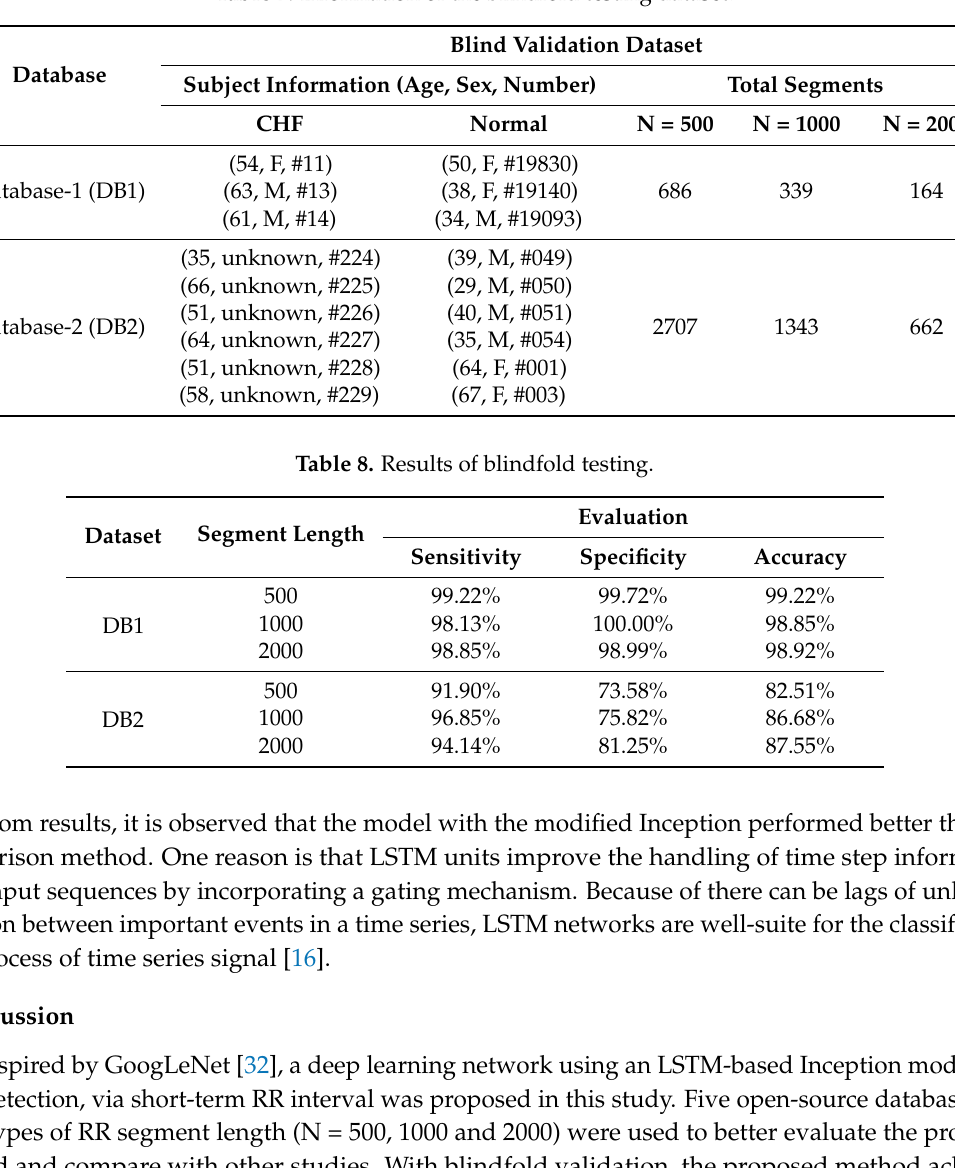
Table 7. Information of the blindfold testing dataset.